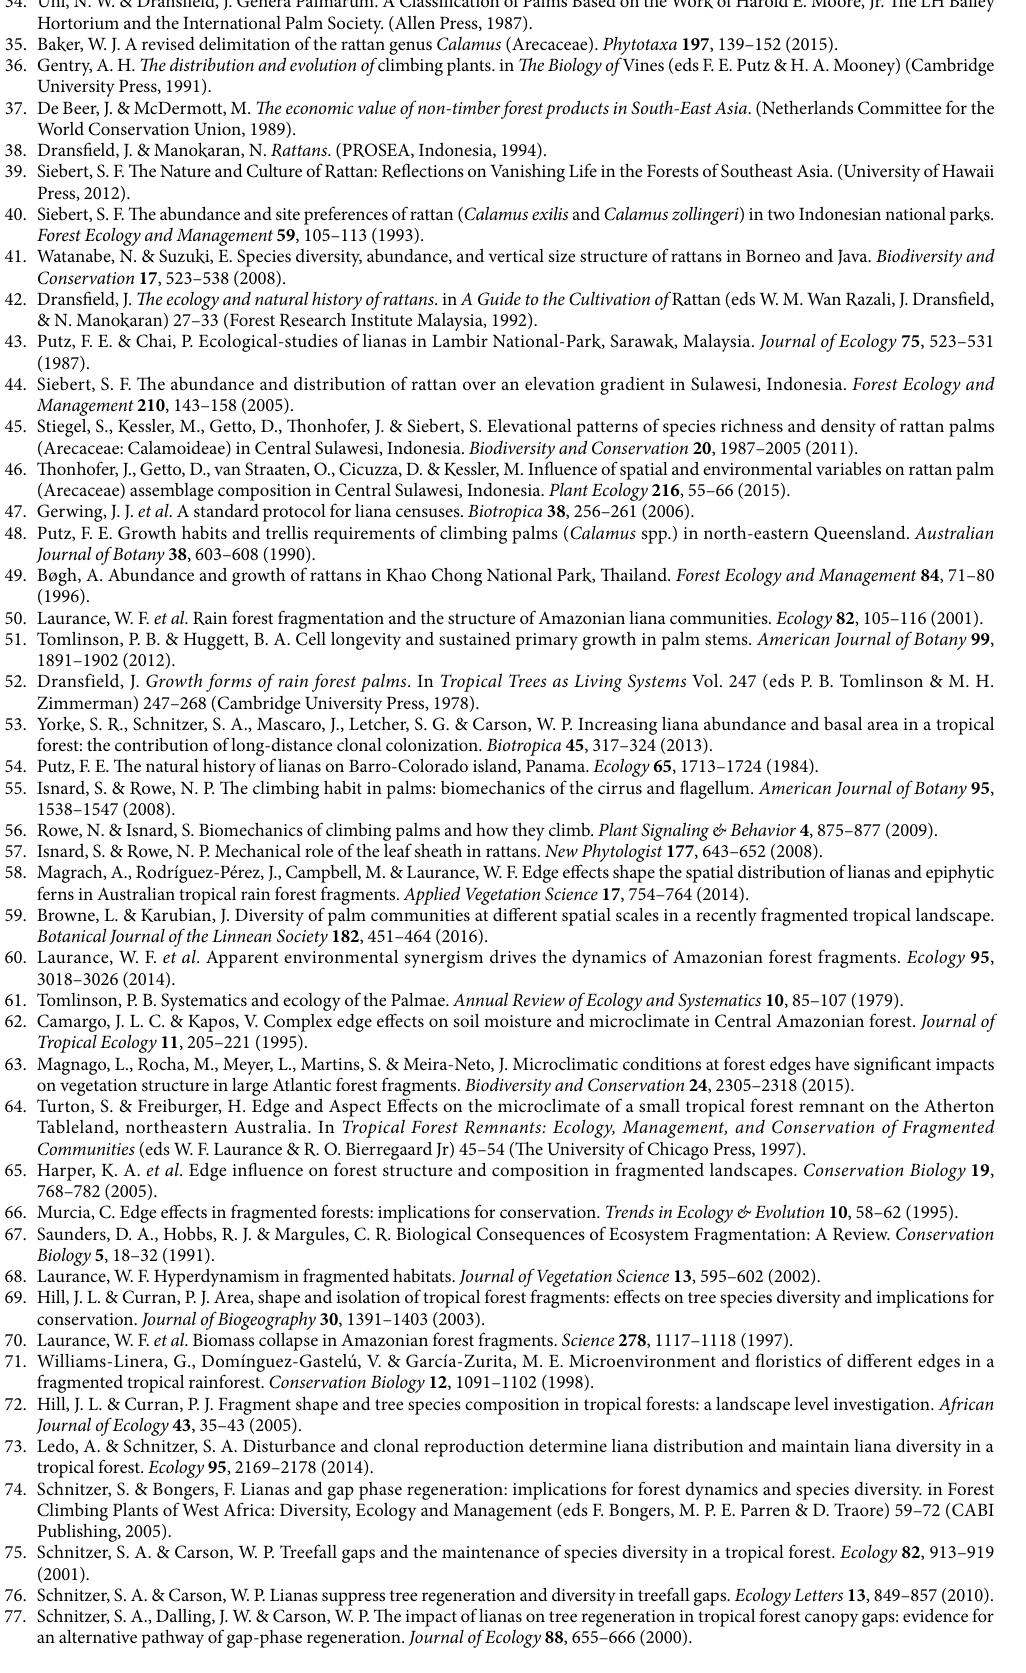
Tableland, northeastern Australia. In Tropical Forest Remnants: Ecology, Management, and Conservation of Fragmented Communities (eds W. F. Laurance & R. O. Bierregaard Jr) 45–54 (The University of Chicago Press, 1997). 65. Harper, K. A. et al . Edge influence on forest structure and composition in fragmented landscapes. Conservation Biology 19 , 768–782 (2005). 66. Murcia, C. Edge effects in fragmented forests: implications for conservation. Trends in Ecology & Evolution 10 , 58–62 (1995). 67. Saunders, D. A., Hobbs, R. J. & Margules, C. R. Biological Consequences of Ecosystem Fragmentation: A Review.